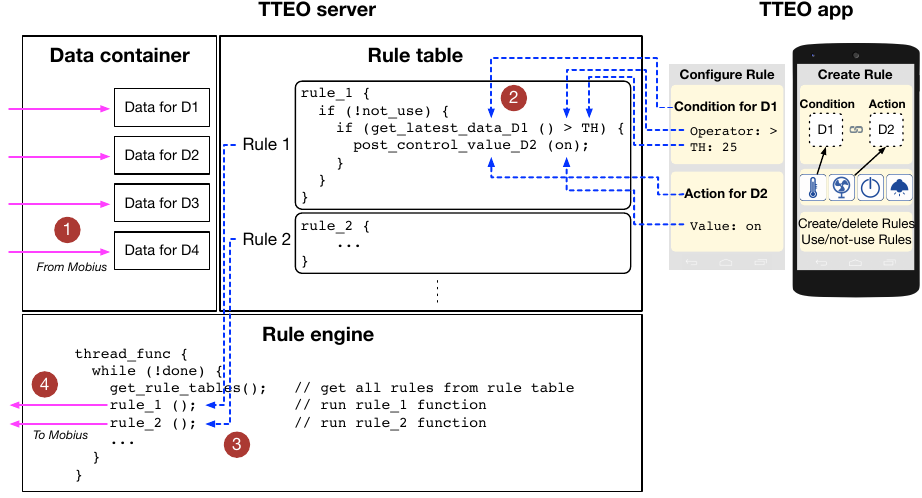
Figure 4. TTEO service server operation: create rules and run its rule engine.